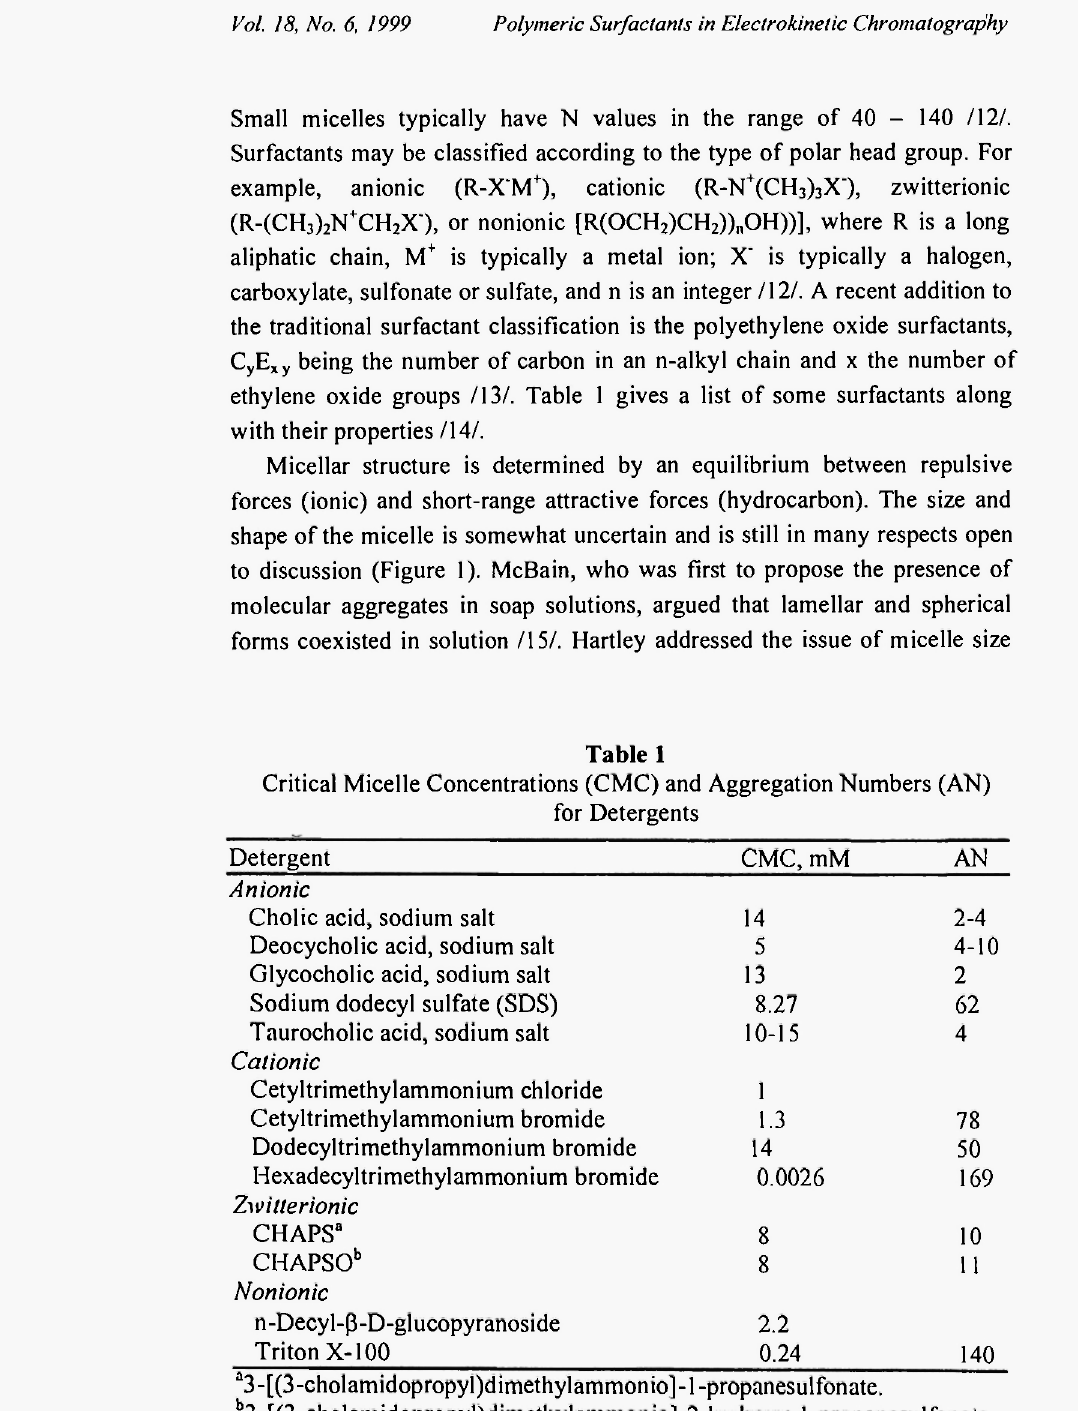
Critical Micelle Concentrations (CMC) and Aggregation Numbers